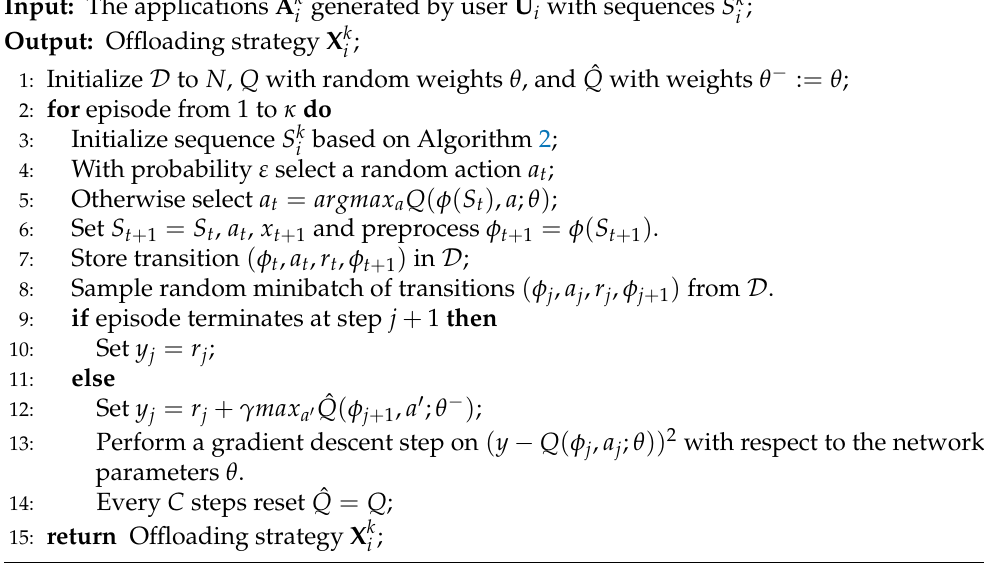
Algorithm 1 Application-driven Task Offloading Strategy based on DQN (ATOS).